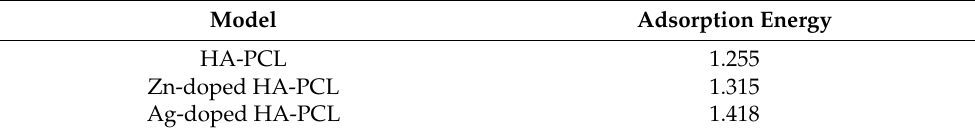
Table 2. Adsorption energy of PCL and HA, Zn-doped HA, and Ag-doped HA (Units: eV).